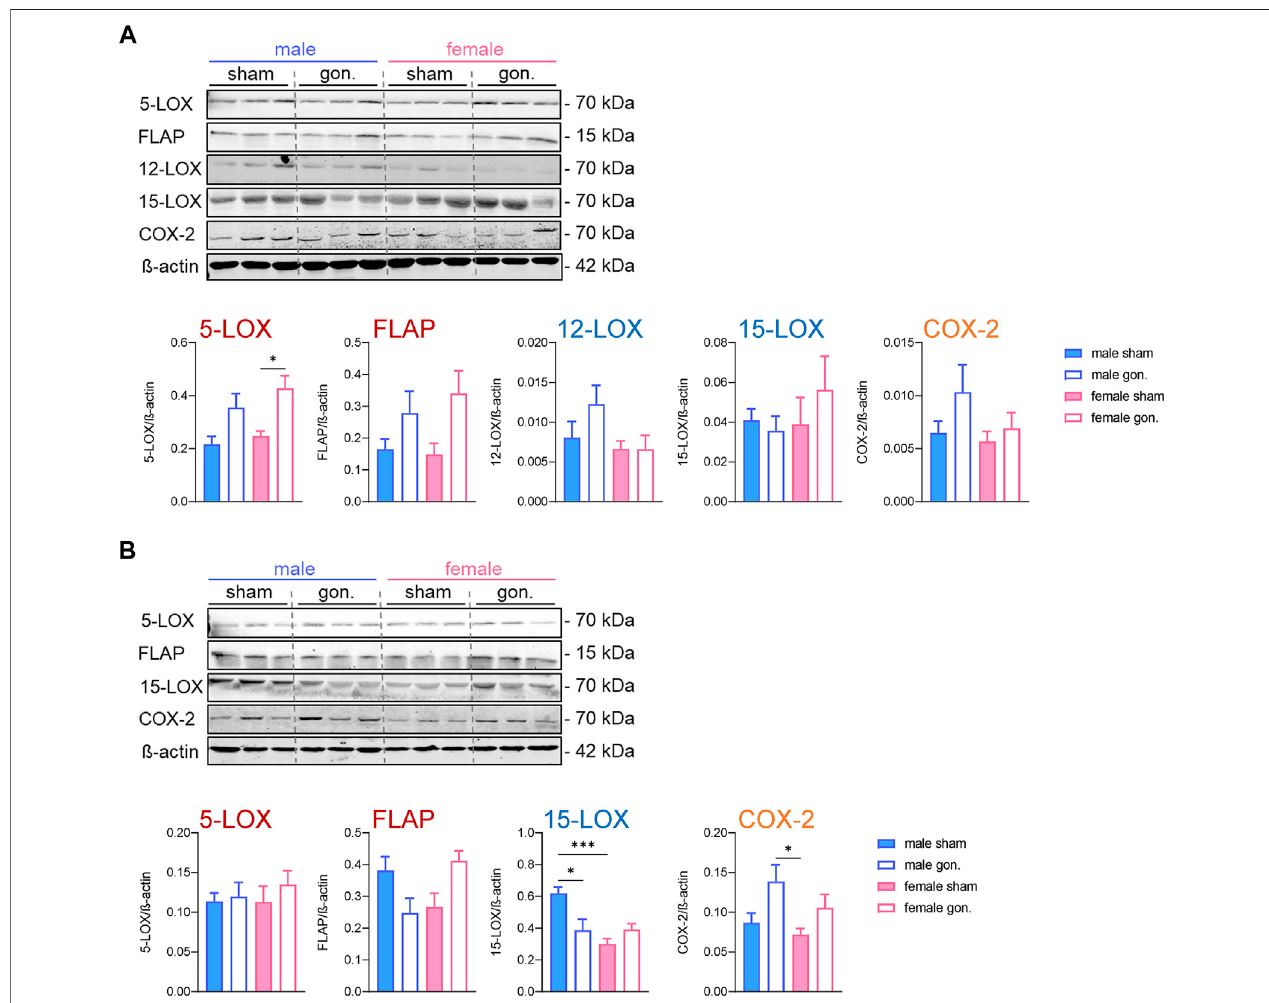
FIGURE 4 | Effect of sex hormone depletion on the expression of LM biosynthetic proteins in peritoneal exudates upon peritonitis induction. Protein levels and the densitometric analysis of 5-LOX, FLAP, platelet-type 12-LOX, 15-LOX, and COX-2 in lysed peritoneal exudates of gonadectomized and non-gonadectomized (sham- operated)maleandfemalemice4 h (A) and24 h (B) afterzymosaninjection,normalizedto β -actin.Westernblotsareshownasrepresentativesfromthreedifferentmice and given as mean values of n (cid:1) 4 – 6; * p < 0.05, ** p < 0.01, ***p < 0.001; one-way ANOVA with Tukey ’ s multiple comparison test for statistical analysis.